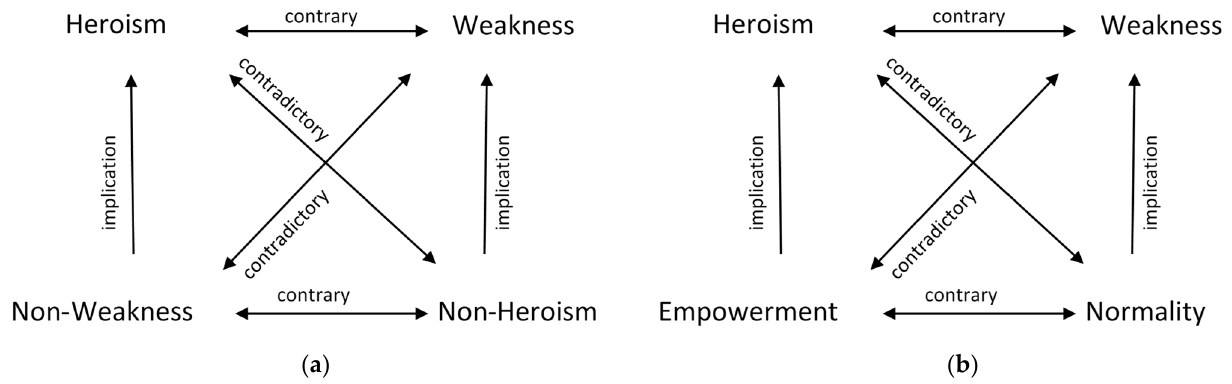
Figure 3. Consequences of semiotic analysis: ( a ) Semiotic square for heroism and weakness; ( b ) Final semiotic square for disability.